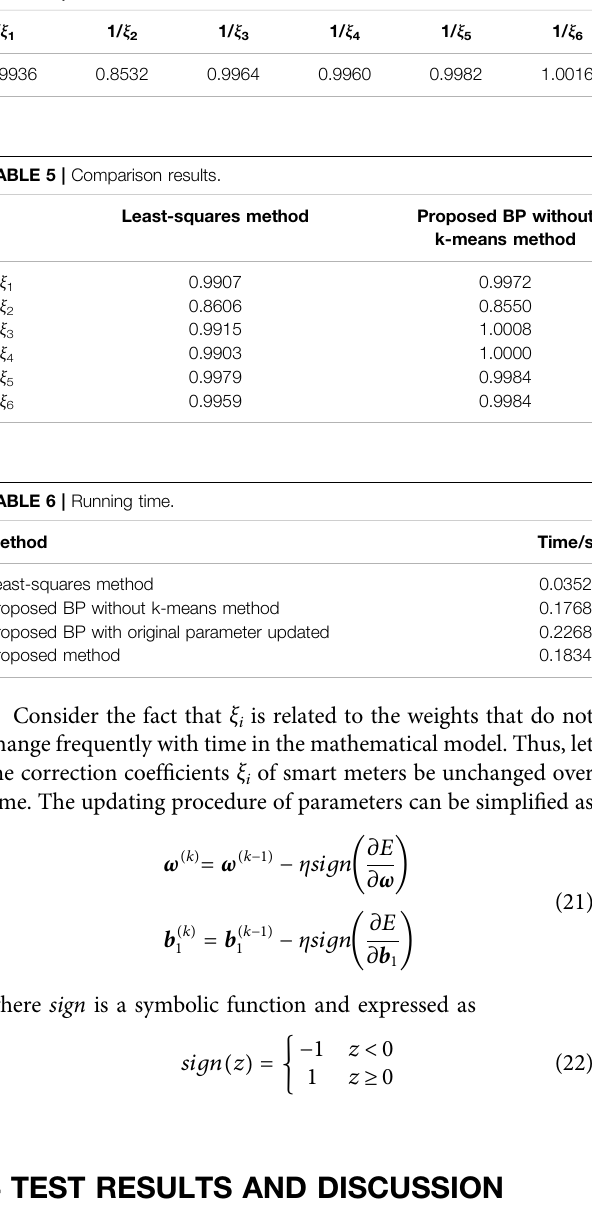
TABLE 4 | Measurement error estimation.